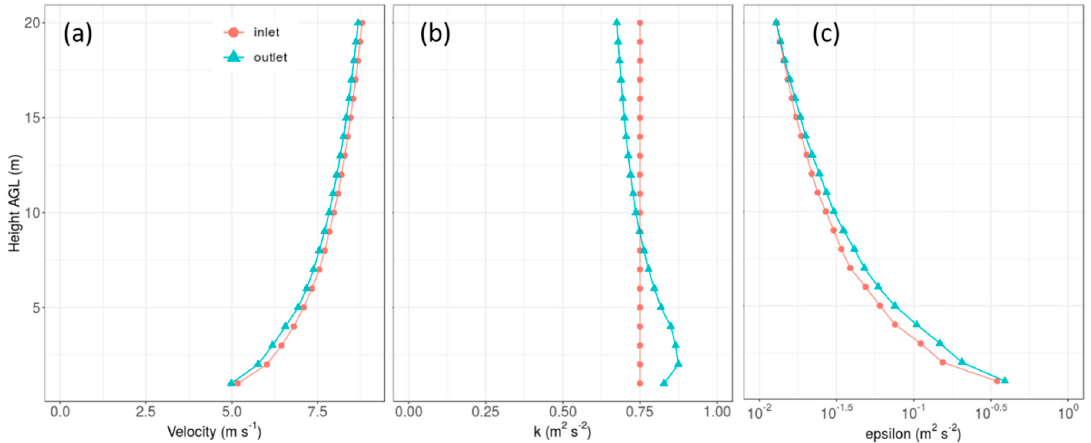
Figure 2. Profiles for ( a ) velocity, ( b ) turbulent kinetic energy (TKE), and ( c ) dissipation of TKE over flat terrain.